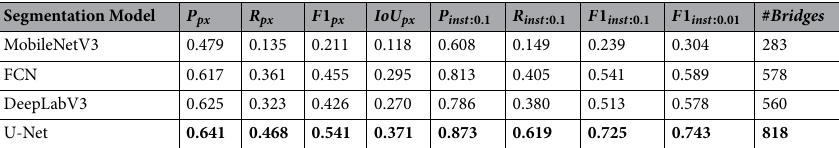
Table 3. Results from different semantic segmentation models. The U-Net outperforms other state-of-the-art segmentation models in this problem on every metrics. Since the dataset suffers from insufficient labels and imbalanced classification, the models with higher model complexity can easily overfit the transferred data. Significant values are in [bold].